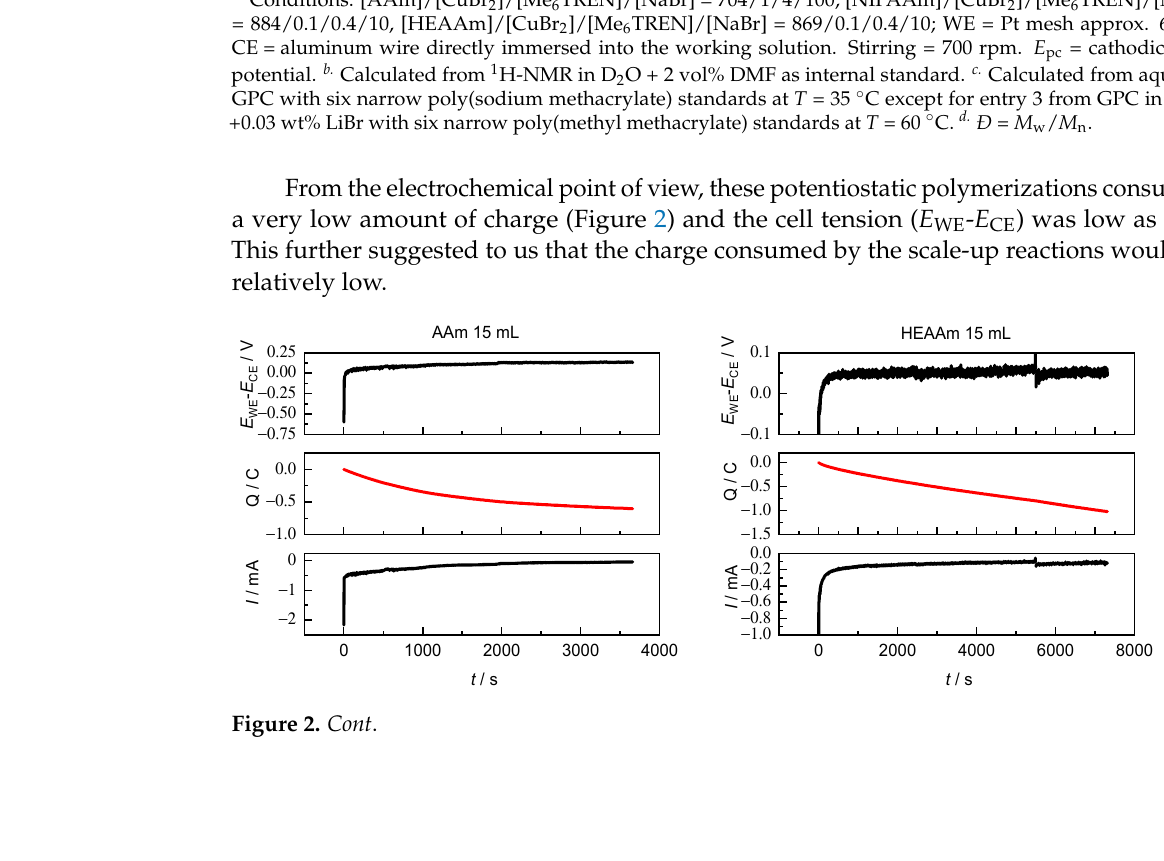
Figure 2. Profiles of E WE - E CE , Q, and I vs. time recorded during the potentiostatic se ATRP of 10 wt% AAm, HEAAm, and NIPAAm in H 2 O +0.1 M NaBr + 0.05 M SP at T = 0 °C. E app = E pc . Working electrode = Pt mesh, counter electrode = Al wire. Both WE and CE have ~6 cm 2 surface area. V = 15 mL. Substrate is cellulose(H)-BriB. In a relatively short time, polymerization reached medium to high conversions. The conversions are similar for NIPAAm and AAm, while the conversion is higher for HEAAm. Đ shows that the cleaved polymers have Đ = 1.15–1.50. We also tried to obtain suitable polymerizations with cellulose (L) substrate (Table 3, entry 2) and AAm as the monomer, but the conversion reached only 40% and Đ was 1.50. As the small-scale results were promising, we sought the possibility to proceed immediately to higher scales. 3.3. Large Volume Polymerizations We decided to introduce galvanostatic se ATRP for all reactions above 15 mL [45,47]. Exceeding this volume, all reactions were driven by two-step galvanostatic electrolysis, deriving I app values knowing: (1) the charge passed (Q); (2) the chronoamperometry pro- files recorded at 15 mL scale (potentiostatic se ATRP); (3) the targeted polymerization vol- ume; and (4) the geometric properties of the reactors, similar to previous works [10]. De- tails of the electrolysis programs are shown in Table 4: Table 4. Electrolysis programs, geometrical reactors details for the candidate polymerization up to 1000 mL (scale-up factor ~67). a. Volume (V f )